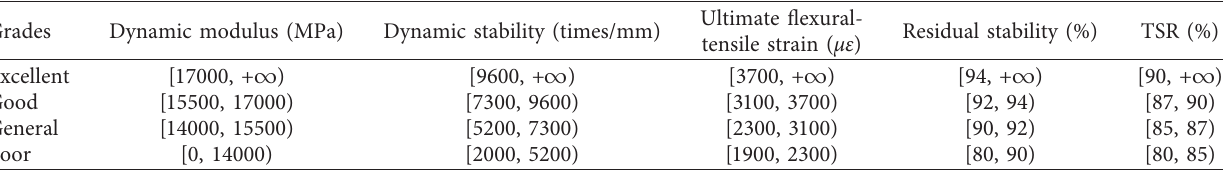
Table 3: Classification standard of self-blending high modulus asphalt mixture.